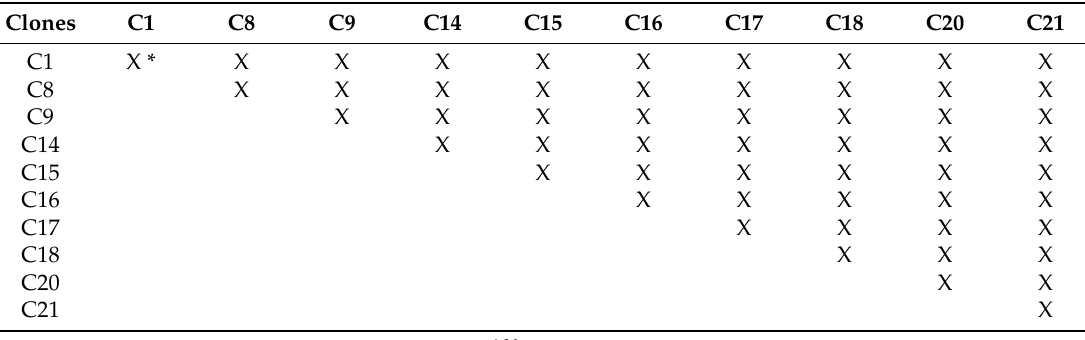
Table 2. Half-diallel design of self- and inter-pollination crosses of the ten